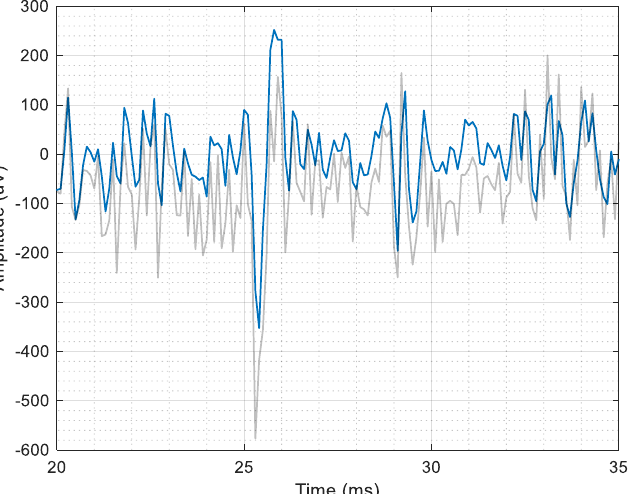
Figure 3. A 15 ms frame of synthetic extracellular signal. In grey the input signal, while the filtered signal is highlighted in blue. One can notice the decrease of noise contribution as well as a light but negligible shift on the right because of non-linear phase of the IIR.